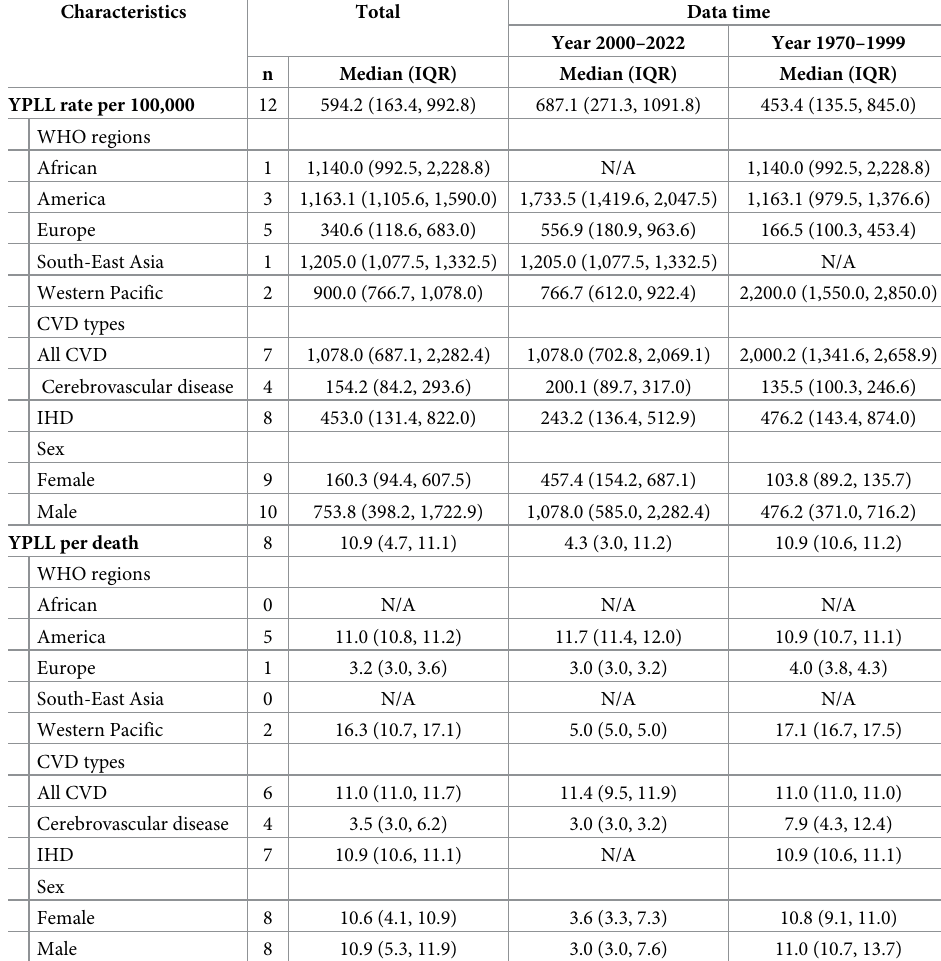
Table 3. Summary of total years of potential life lost (YPLL) from CVD mortality according to study